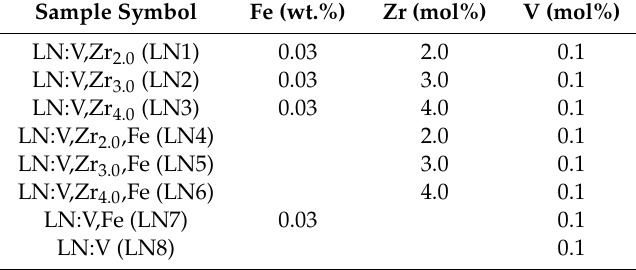
Table 1. Composition ratio of various iron, zirconium, and vanadium co-doped LN crystals. Sample